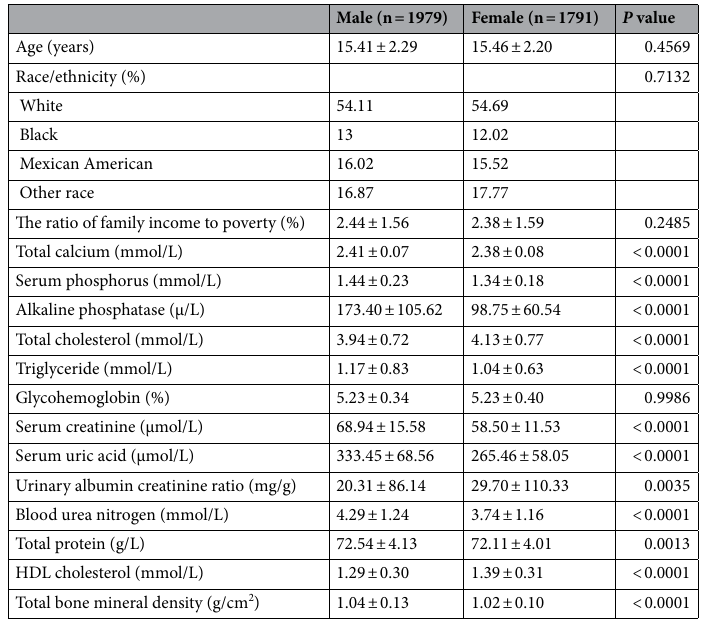
Table 1. Weighted characteristics of the sample in this study. Continuous variables were represented via mean ± SD, calculated using a weighted linear regression model. Categorical variables were presented via %. Calculated by The chi-square